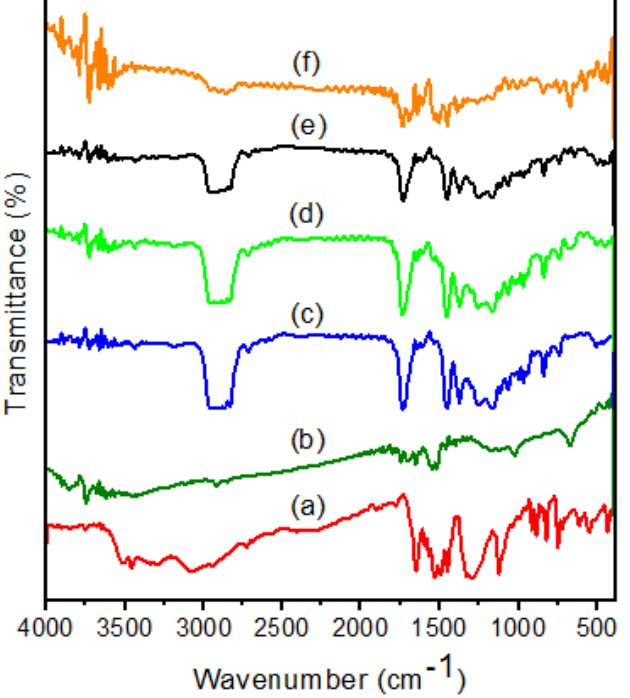
Figure 2. FTIR spectra of ( a ) pure PVA, ( b ) PPy, and PVA/PPy/KI/I 2 electrolytes with various plasticizers (in 10 wt.%); ( c ) EC, ( d ) PC, ( e ) GBL, and ( f ) DBP.